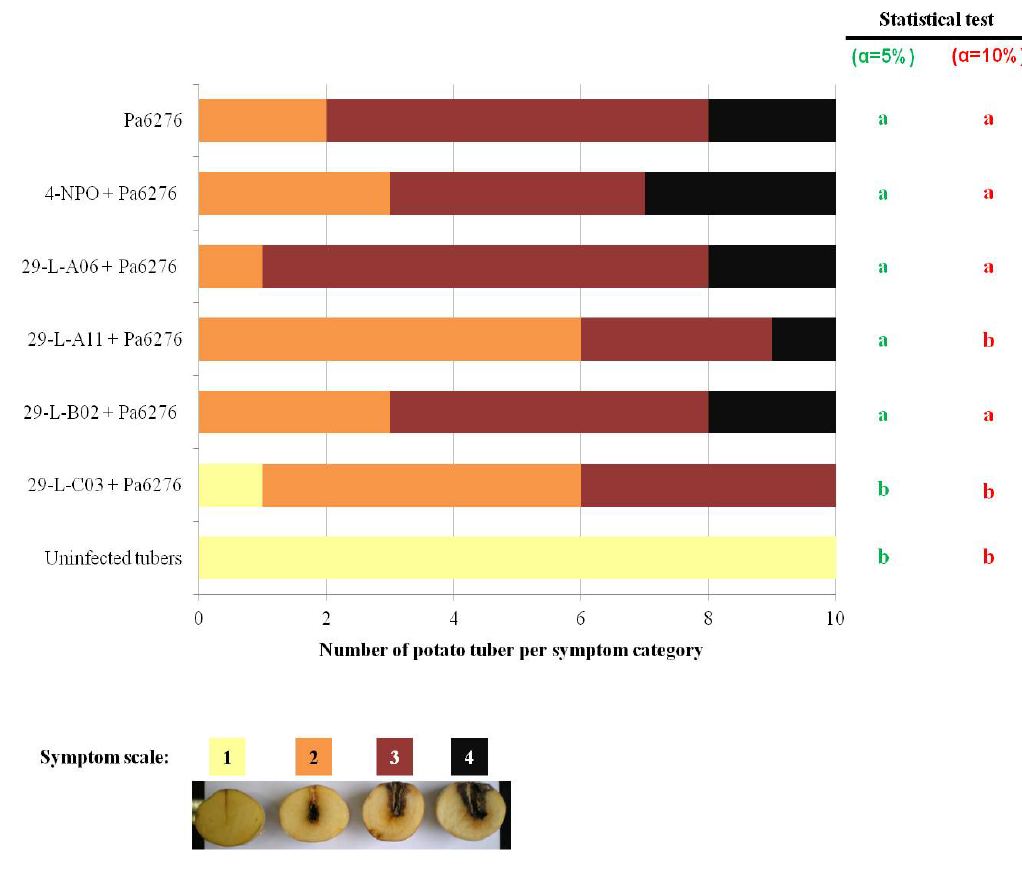
Figure 2. QSIs and soft-rot tuber assay. Each tuber of S.tuberosum was inoculated with 10 7 cells of P. atrosepticum CFBP6276 (Pa6276) in the absence and presence of the QSIs at 20 µM. The uninfected tubers were used a negative control. The virulence symptoms are categorized according a four-category scale. The different letters indicate the symptoms of QSI-treated conditions which were statistically different to those obtained in the presence of Pa6276 alone (Kruskal and Wallis test, α = 5% or